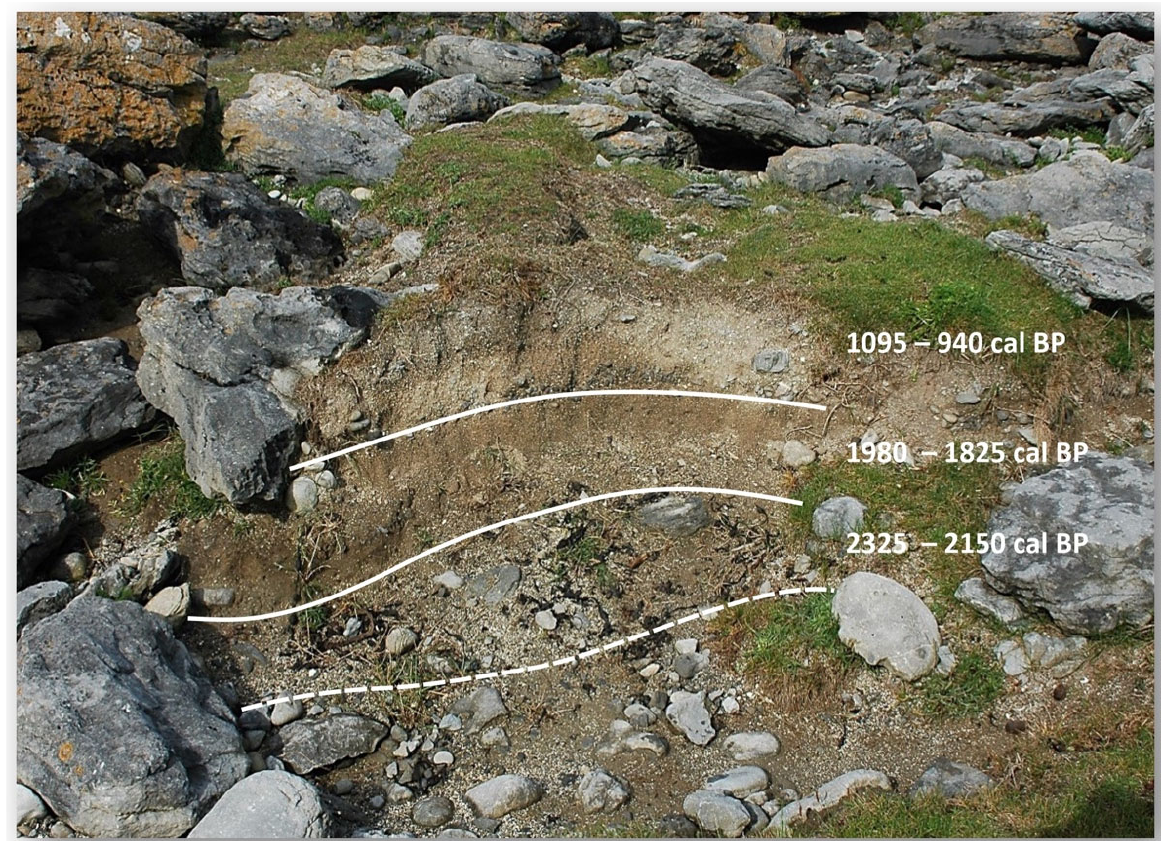
Figure 13. Strata with basal erosional unconformity that are graded with upward fining. Ages point to different events (about 20 km inside Galway Bay at its southeast coastline) [65,125].